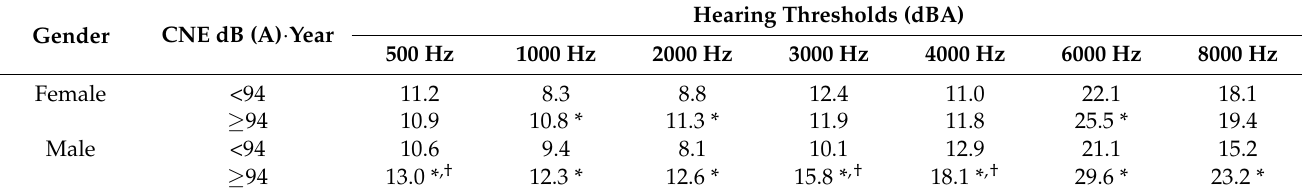
* The average thresholds in better ear of noise-exposed workers with CNE ≥ 94 dB (A) · year were significantly higher than workers with CNE < 94 dB (A) · year within female and male workers ( p < 0.05). † The average thresholds in better ear of noise-exposed male workers with CNE ≥ 94 dB (A) · year were significantly higher than those of female workers with CNE ≥ 94 dB (A) · year ( p <